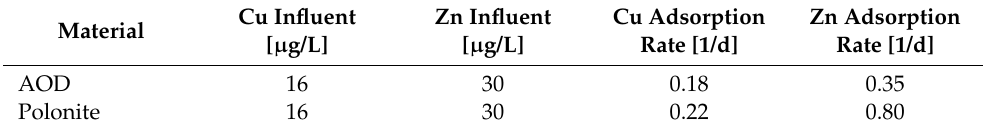
Table 4. Parameters used to run the model.